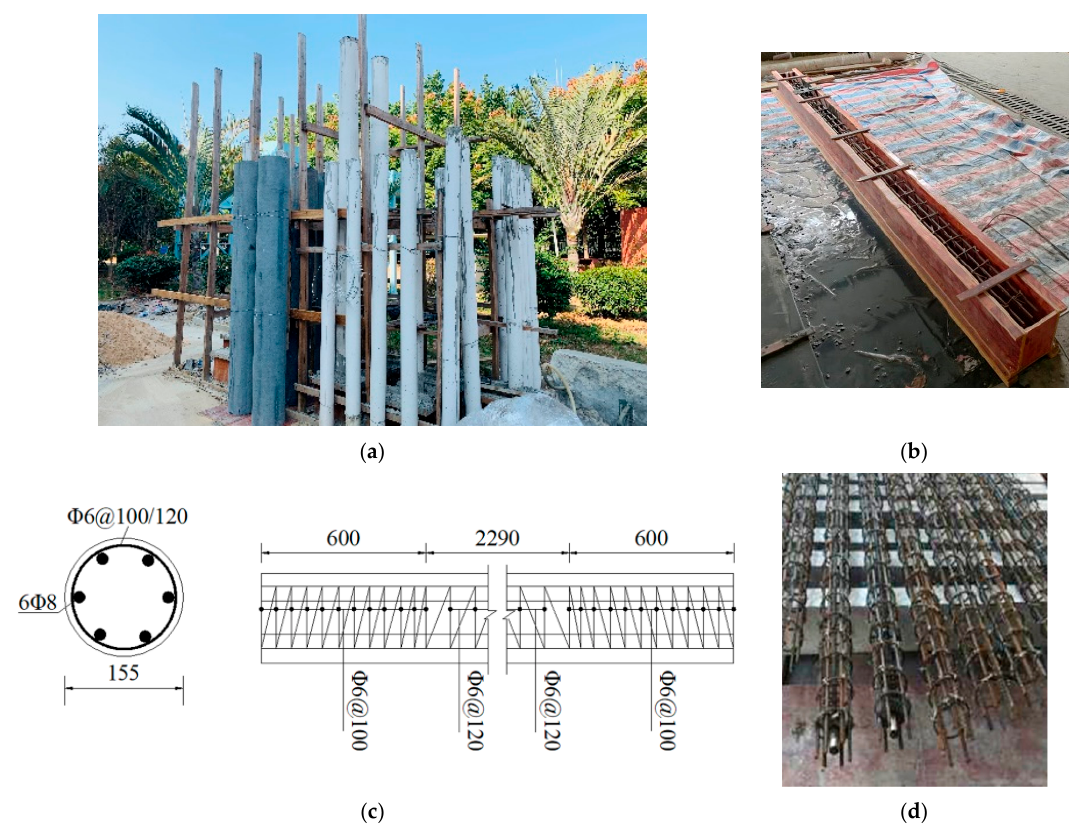
Figure 2. Fabrication of the specimens (unit: mm). ( a ) Construction of the circular piles. ( b ) Construction of the rectangular pile. ( c ) Reinforcement detailing of circular specimens. ( d ) Reinforcements of circular piles.